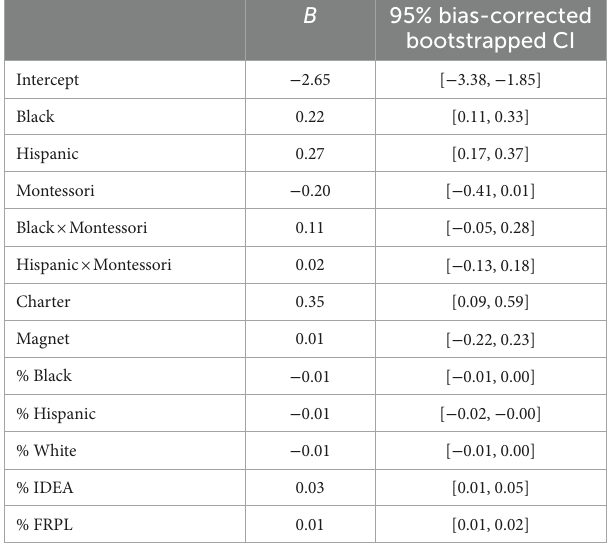
TABLE 4 Chronic absenteeism disparities between racial groups across Montessori and non-Montessori schools and bootstrapped (5000×) 95% bias-corrected confidence intervals for multilevel